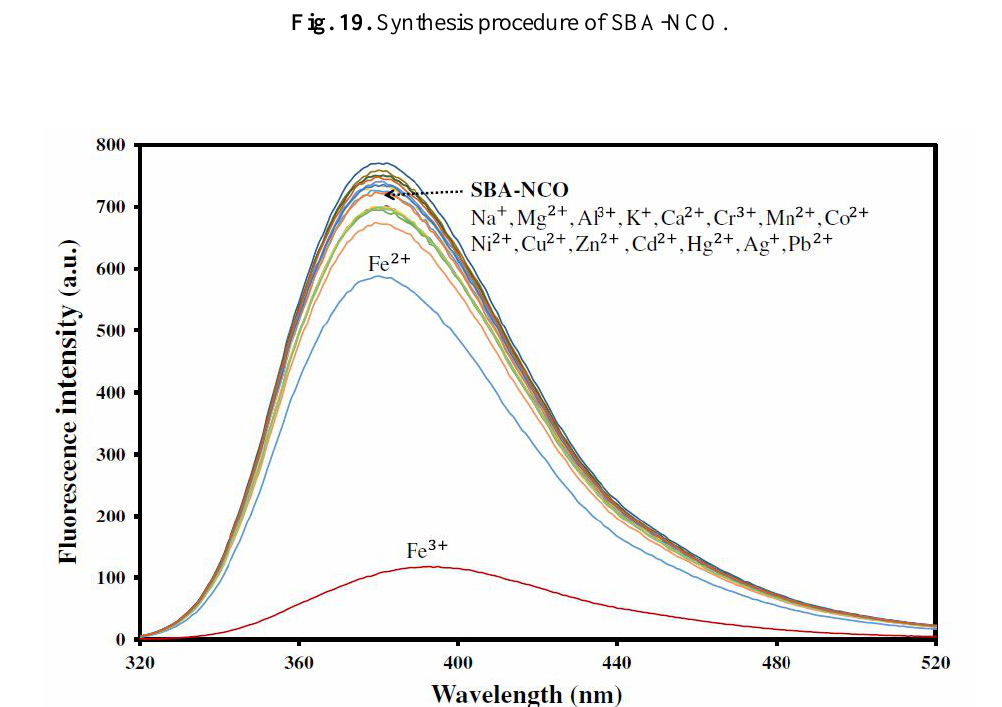
Fig. 20. Fluorescence spectra of the suspended SBA-15-NCO in the presence of various cations